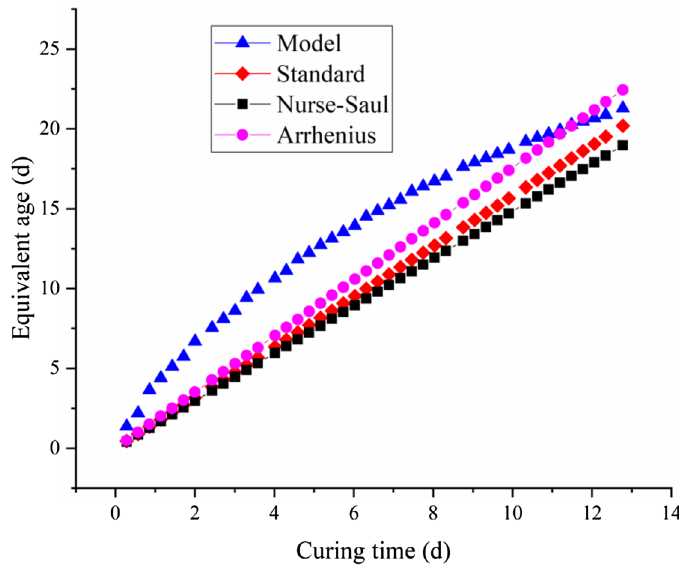
Figure 8. Comparison of equivalent age by different methods under constant-temperature curing conditions.